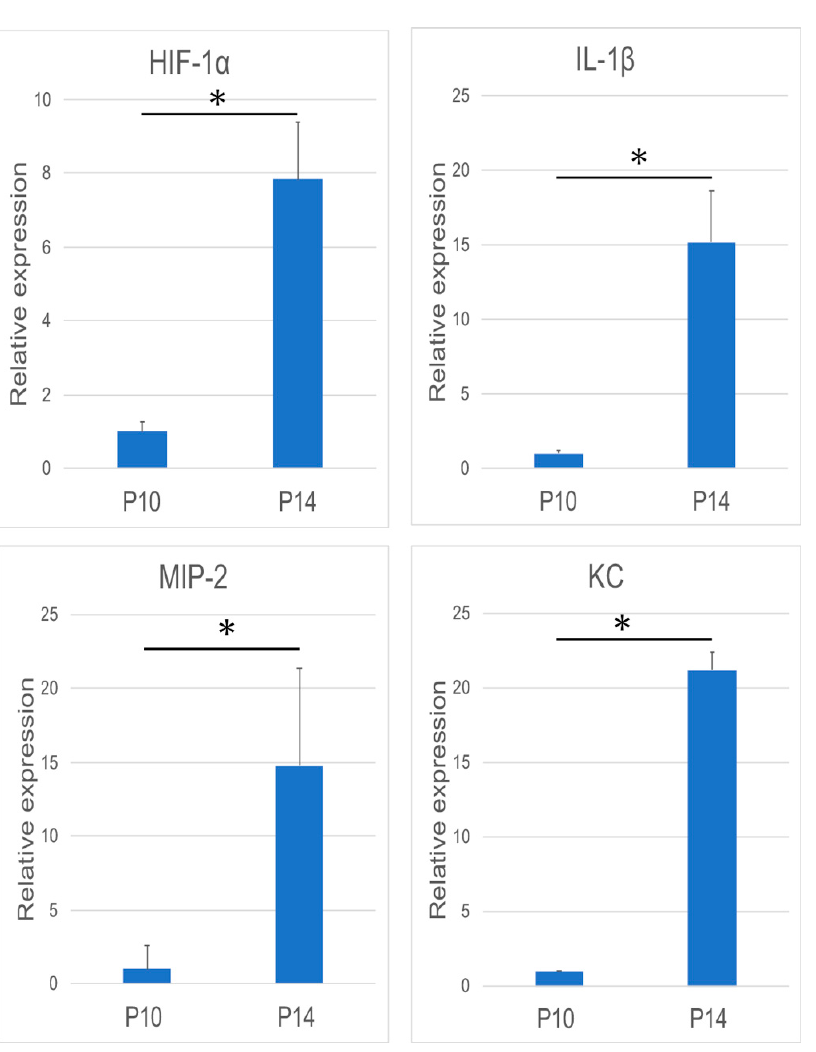
Figure 2. Analysis of the mRNA expression of Mm00468869_m1 (HIF-1 α ), Mm01336189_m1 (IL-1 β ), macrophage inflammatory protein-2 (MIP-2), and keratinocyte-derived chemokine (KC) using reverse transcription-polymerase chain reaction (RT-PCR) (n = 9 in each group). In general, the mRNA expression of these four molecules was significantly increased during the tooth eruption. (* p < 0.05).